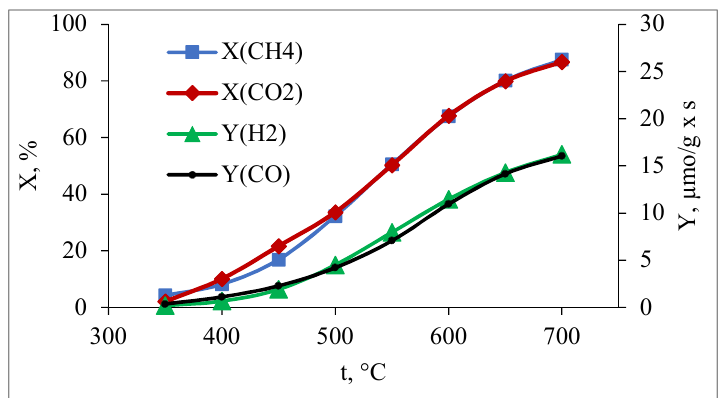
Figure 6. Effect of temperature on CO 2 -CH 4 conversion and yield of H 2 -CO in DRM over 5%Co- Rh(98:2)/Al 2 O 3 at CH 4 :CO 2 :Ar, P = 1 atm, GHSV = 1000 h − 1 .